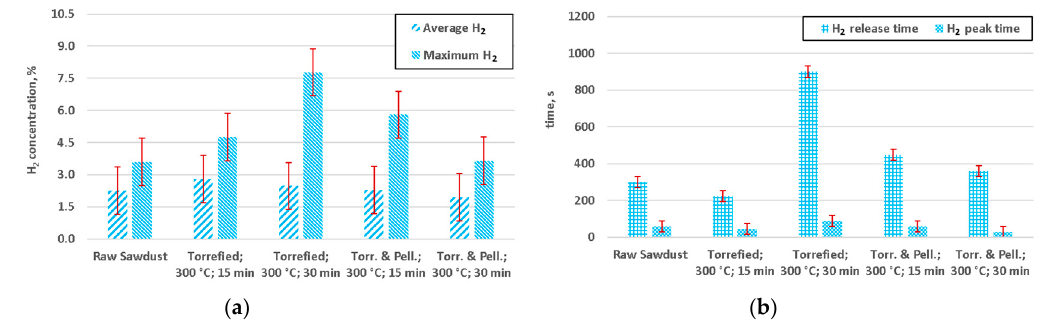
Figure 8. H 2 concentration for preformed gasification experiments: ( a ) average concentrations of hydrogen; ( b ) release time and the time of peak concentration (Torr. & Pell. – torrefied and pelletized).